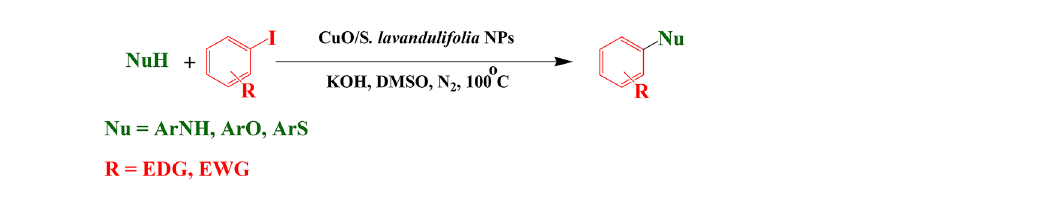
Scheme 1. C–heteroatom cross coupling reactions over CuO